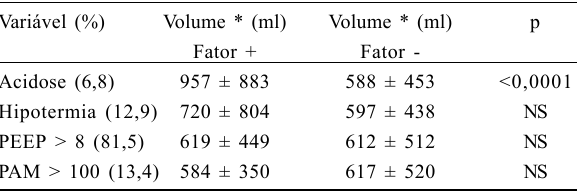
Tabela 5. Fatores de risco pós-operatórios estudados através de análise